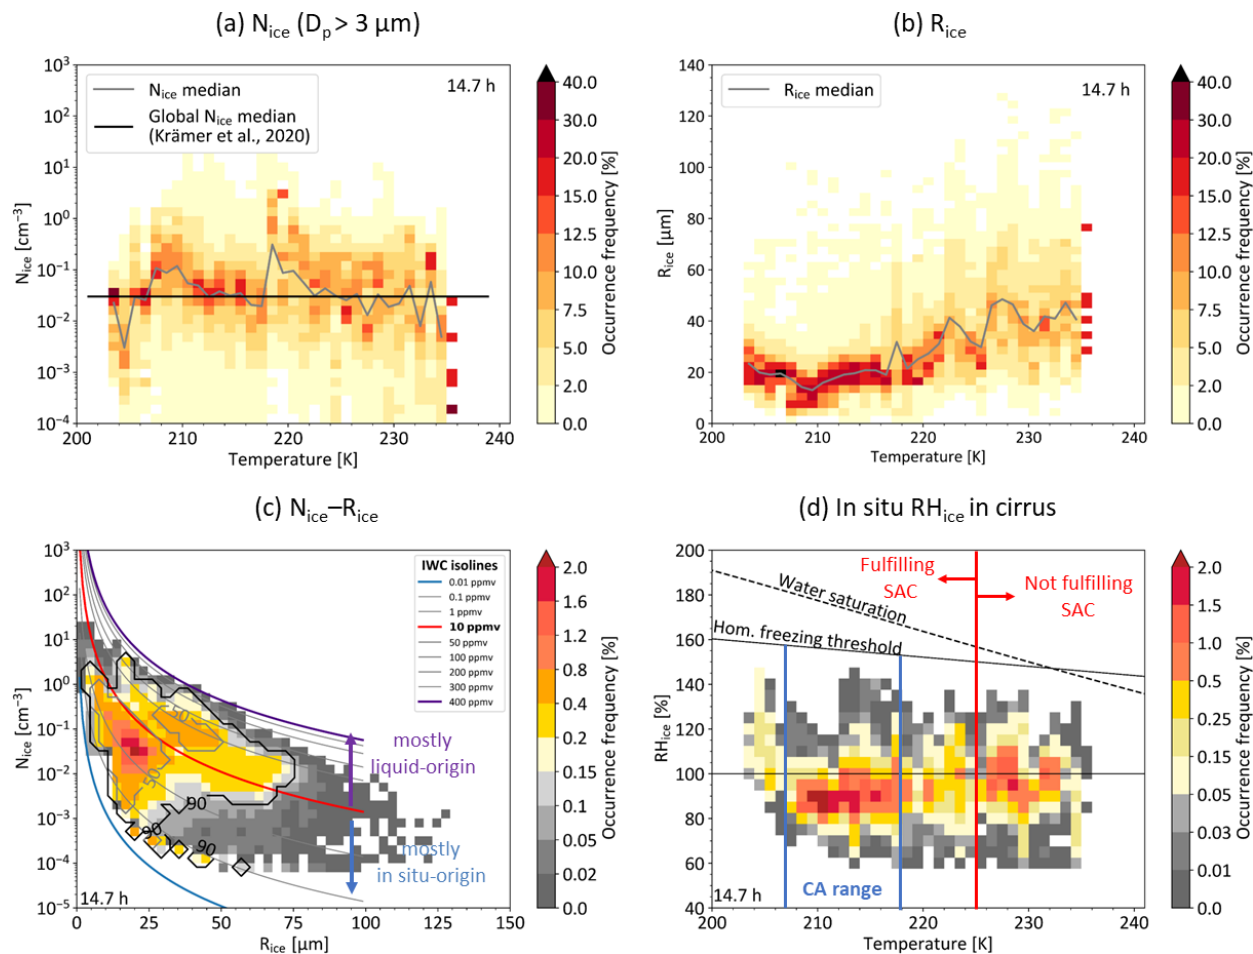
Figure 3. Overview of the cirrus cloud properties measured in central Europe and the northeast Atlantic flight corridor during the ML- CIRRUS research aircraft campaign in spring 2014. (a) Occurrence frequency of ice particle number concentrations ( N ice ) for all cirrus crystals larger than 3µm in diameter ( D p ), binned in 1K intervals. The grey line shows the median N ice in single temperature intervals. The horizontal bar indicates the N ice median from in situ N ice global climatology (Krämer et al., 2020). (b) The same as (a) but for the mass mean radius R ice of cirrus particles. (c) Normalized occurrence frequency of N ice as a function of R ice . Coloured curves are ice water content (IWC) isolines in parts per million by volume (ppmv). The same amount of IWC could consist of many small ice particles pointing to the left end of the isoline or a few large ice crystals to the right end. The grey and black contours enclose 50% and 90% of the most frequently occurring cloud particles. Ice crystals with IWC < 10ppmv are mostly in situ-origin cirrus, while those with IWC > 10ppmv are mostly liquid-origin cirrus. (d) Normalized occurrence frequency of in situ RH ice in cirrus clouds. The water saturation (Murphy and Koop, 2005) and homogeneous freezing threshold (Koop et al., 2000) are added. The vertical red line marks the temperature threshold for possible contrail formation, calculated from the Schmidt–Appleman criterion (SAC). The most frequent aircraft cruising altitude boundaries are marked by the vertical blue lines and correspond to a pressure range of 200–245hPa (207–218K in temperature).